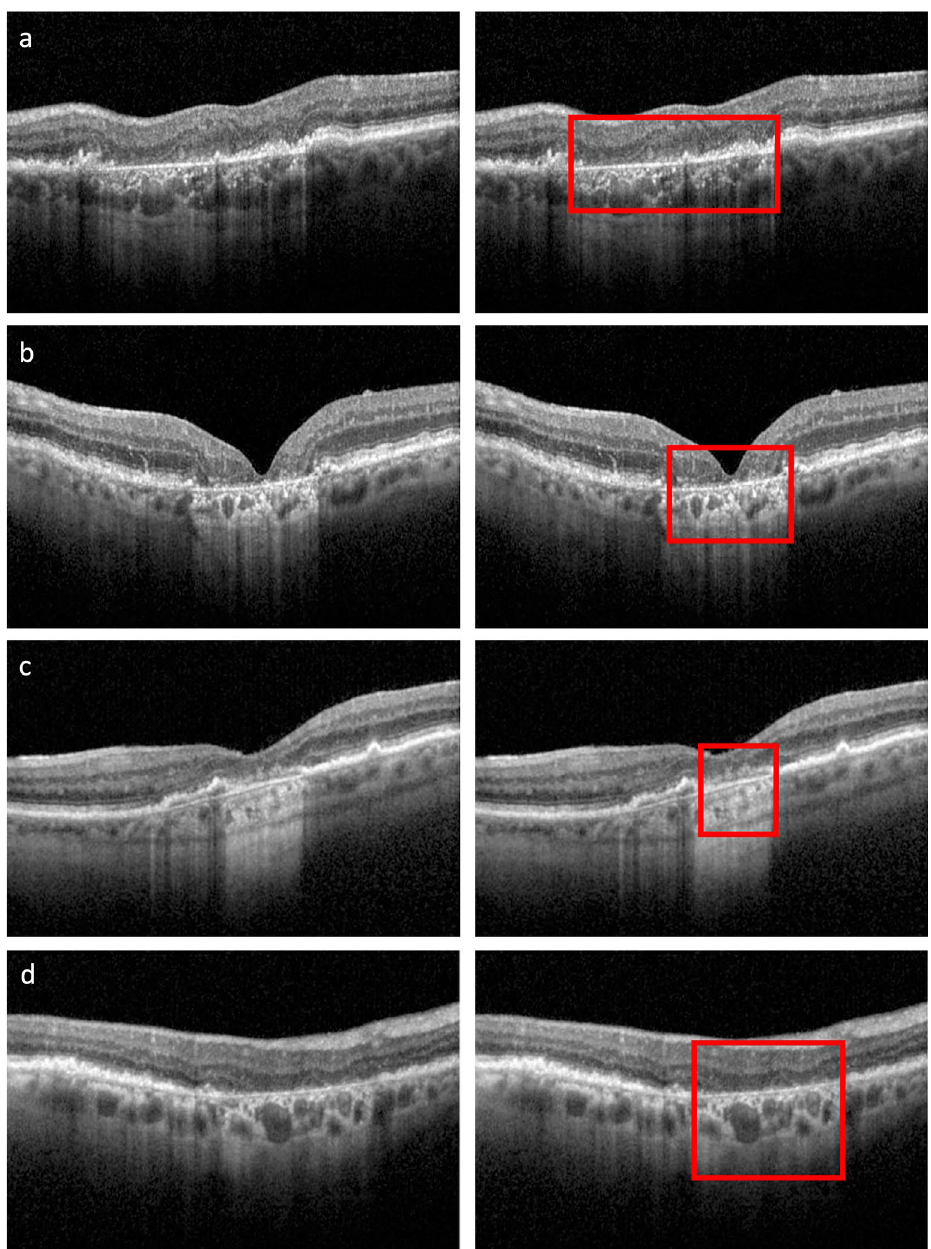
Figure 1. Examples of an OCT b-scan (left) and corresponding manual RORA segmentation (right). ( a ) Hypertransmission in the choroid is present within the annotated region. The status of the RPE is attenuated in the right part of the square and absent in the left part. ( b ) Clear presence of hypertransmission in the choroid, absence of the RPE line, and severe alteration of the photoreceptors. ( c ) Clearly altered but still present RPE layer within the annotated region. The RORA criteria are not fulfilled for the region to the left of the square, as there is incomplete hypertransmission and elevated RPE without significant attenuation. ( d ) Example of weak hypertransmission despite absence of the retinal pigment epithelium and existing